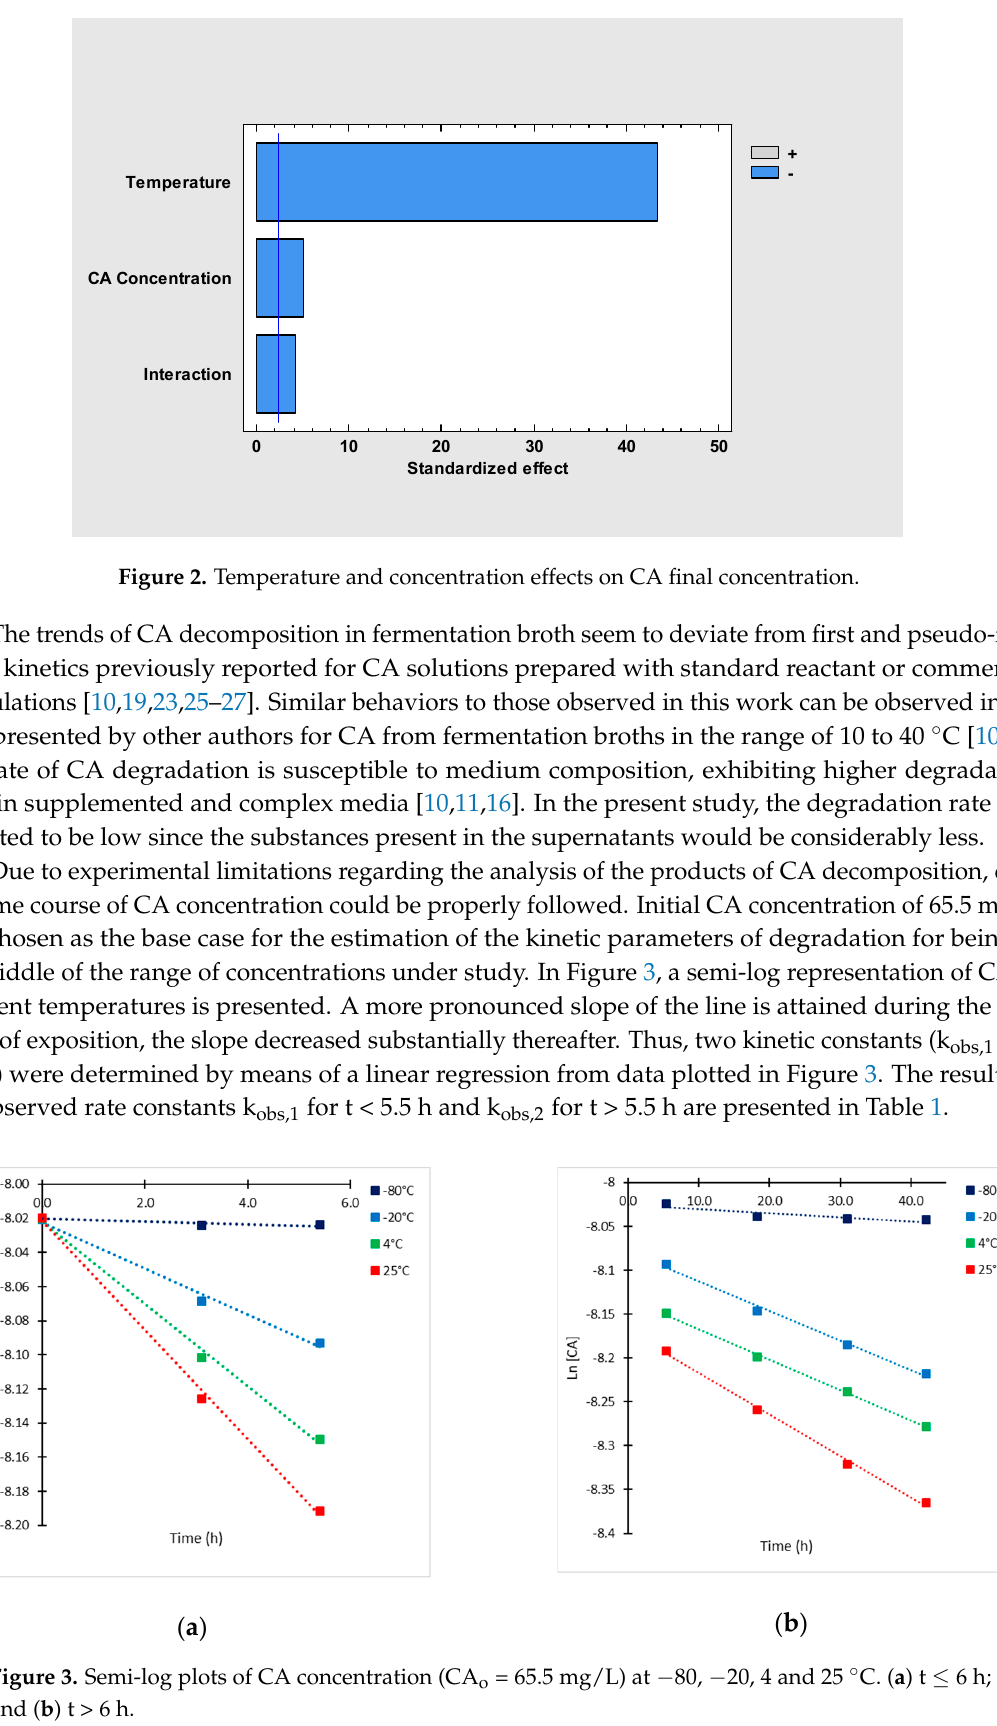
Figure 3. Semi-log plots of CA concentration (CA o = 65.5 mg/L) at − 80, − 20, 4 and 25 °C. ( a ) t ≤ 6 h; and ( b ) t > 6 h. Table 1. Observed reaction rate constants for t < 5.5 h (k obs,1 ) and t > 5.5 h (k obs,2 ) at − 80, − 20, 4 and 25 °C. Temperature t < 5.5 h